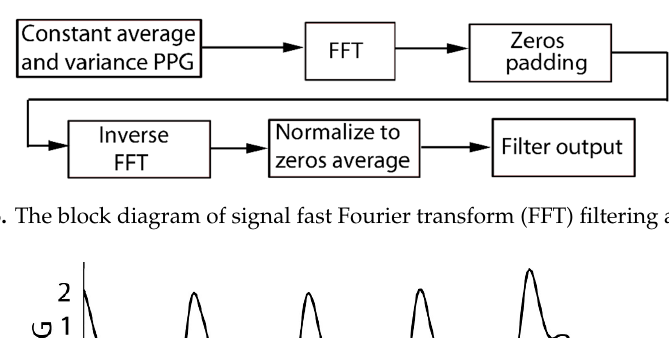
Figure 7. Filtered signal in SPW.